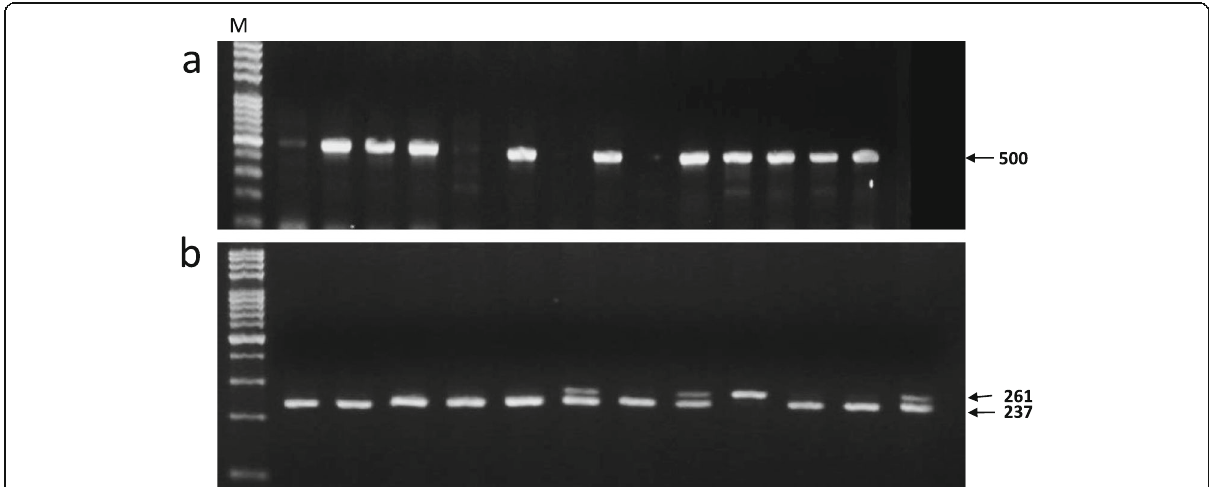
Fig. 1 The HPSE SNP genotyping from Egyptian patients with HCC and control individuals by agarose gel electrophoresis. a genotyping of HPSE rs12331678 by ARMS-PCR as the first 2 lanes are CC genotype and the lanes 3 and 4 are CA genotype. b genotyping of HPSE rs12503843 by RFLP-PCR; CC genotype product 237 bp, while CT genotype 237 and 261 bp and TT genotype 261